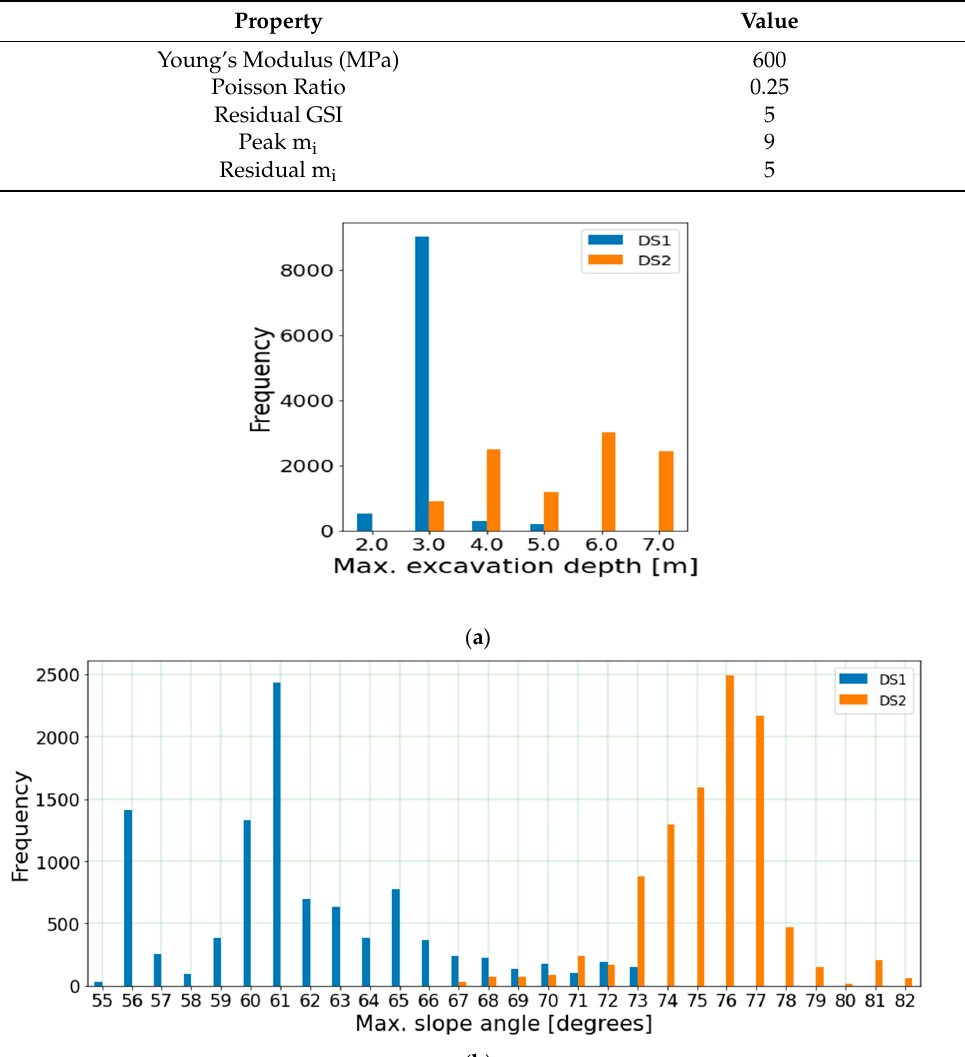
Table 3. Constant value parameters.